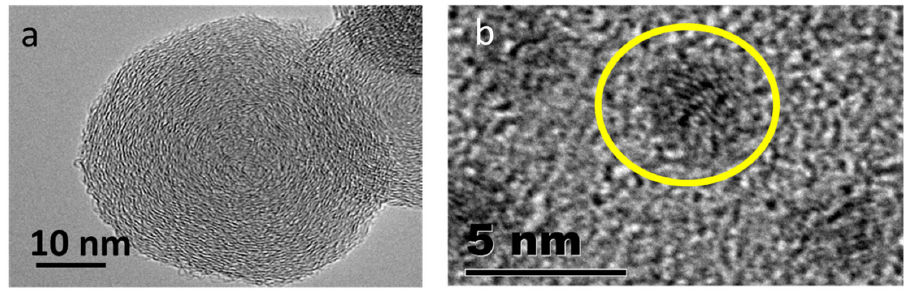
Figure 5. TEM image of a carbon nano ‐ onion ( a ) and carbon dot ( b ). Image courtesy from Neil J. Coville.